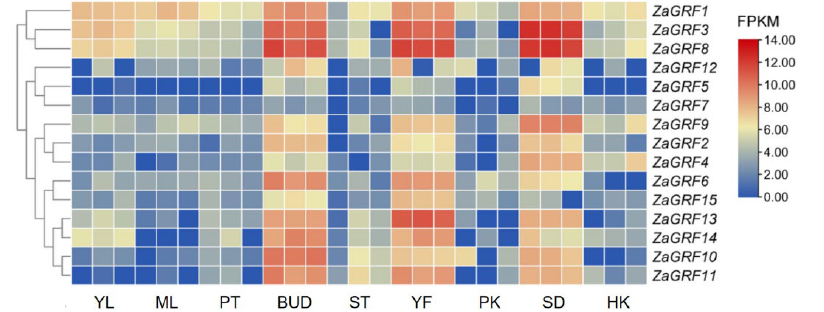
Figure 7. Tissue-specific expression pattern of ZaGRF genes. The heatmap was generated based on in silico analysis of the tissue-specific expression data of ZaGRF genes from the SRA database, and normalized log2 transformed values were used with hierarchical clustering. The transition from blue to red represents different expression levels. YL: young leaf; ML: mature leaf; PT petiole; BUD: terminal bud; STEM: stem; YF: young flower; PK: prick; SEED: seed; HK: husk.